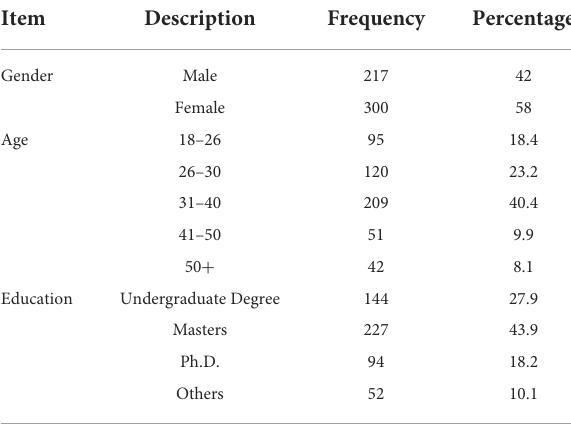
TABLE 2 Profile of